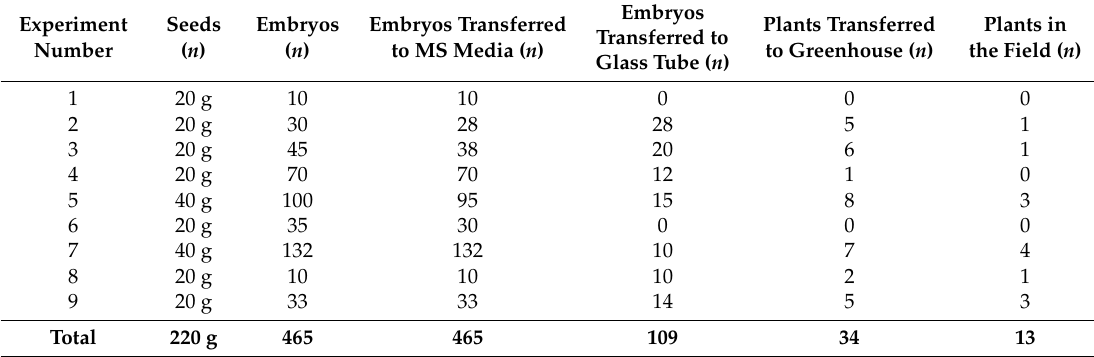
Table 1. Efficiency of cotton plant transformation with the V β